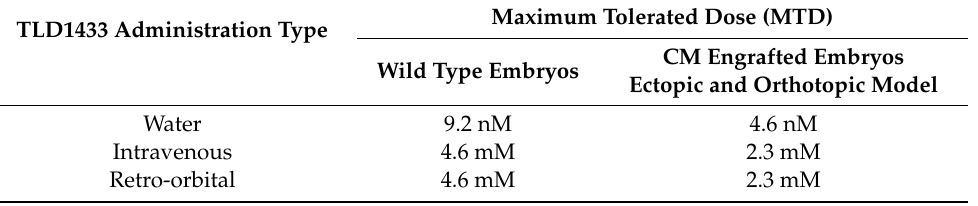
Table 2. The maximum tolerated dose (MTD) of TLD1433 in wild type zebrafish embryos and in the ectopic and orthotopic CM tumour